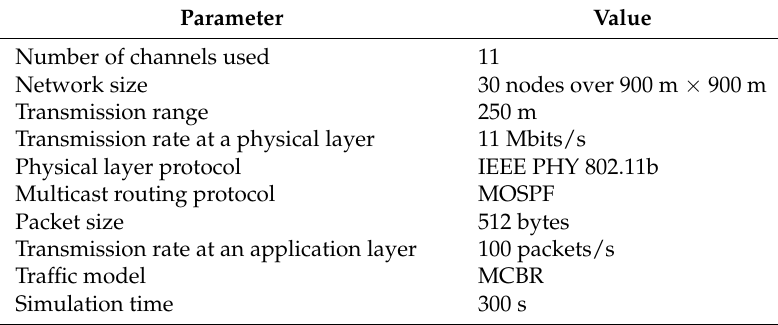
Table 2. Simulation